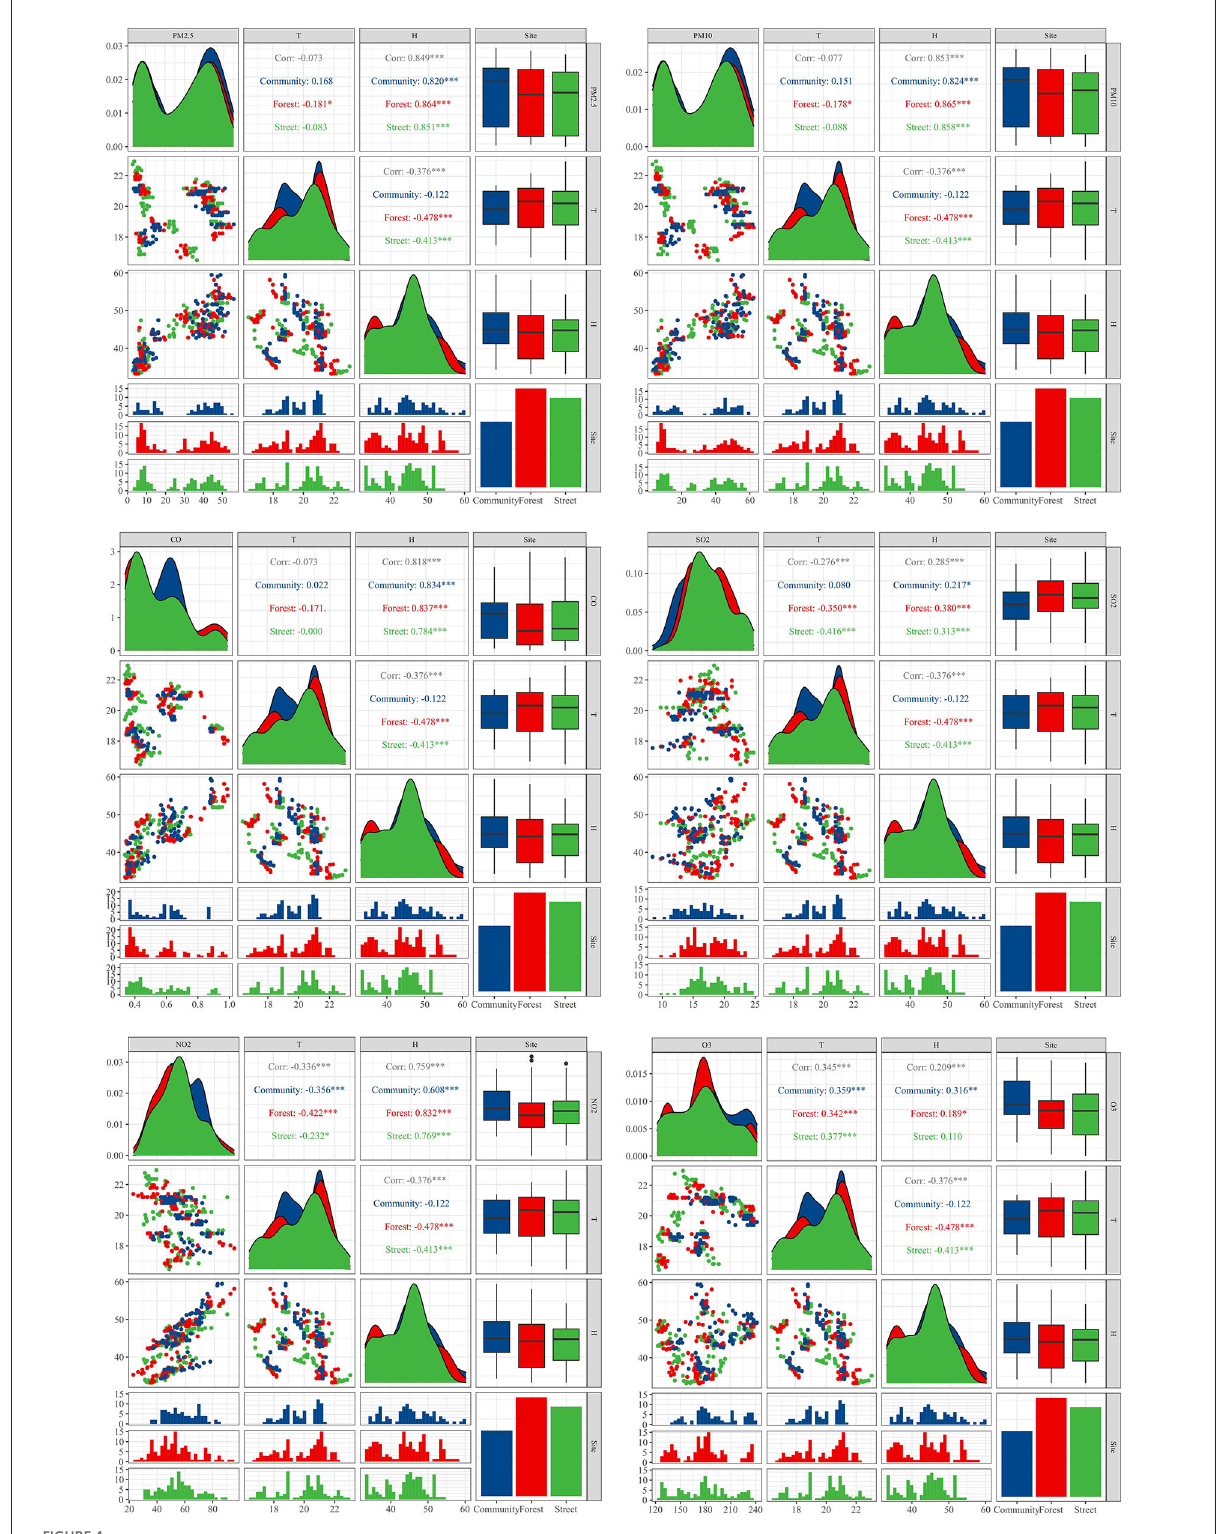
FIGURE4 Pair plots for viewing correlation and distributions of air pollutant concentrations, air temperature, and relative humidity. The numbers in the figure show Pearson’s correlation coefficient between air pollutants and relative humidity and air temperature totally in the community, forest, and street,